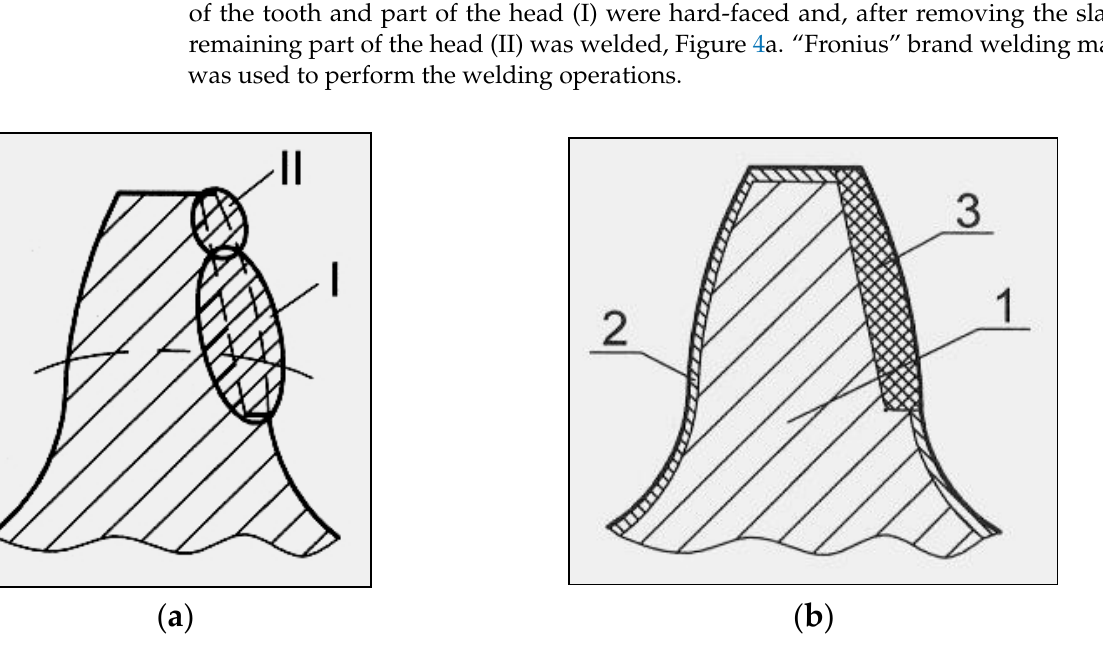
Figure 4. ( a ) Appearance of the tooth hard-faced in two passes; ( b ) Appearance of the tooth cross- section after the reparative hard-facing and machining (1—the tooth core; 2—the cemented layer; 3—the hard-faced part of the tooth flank).